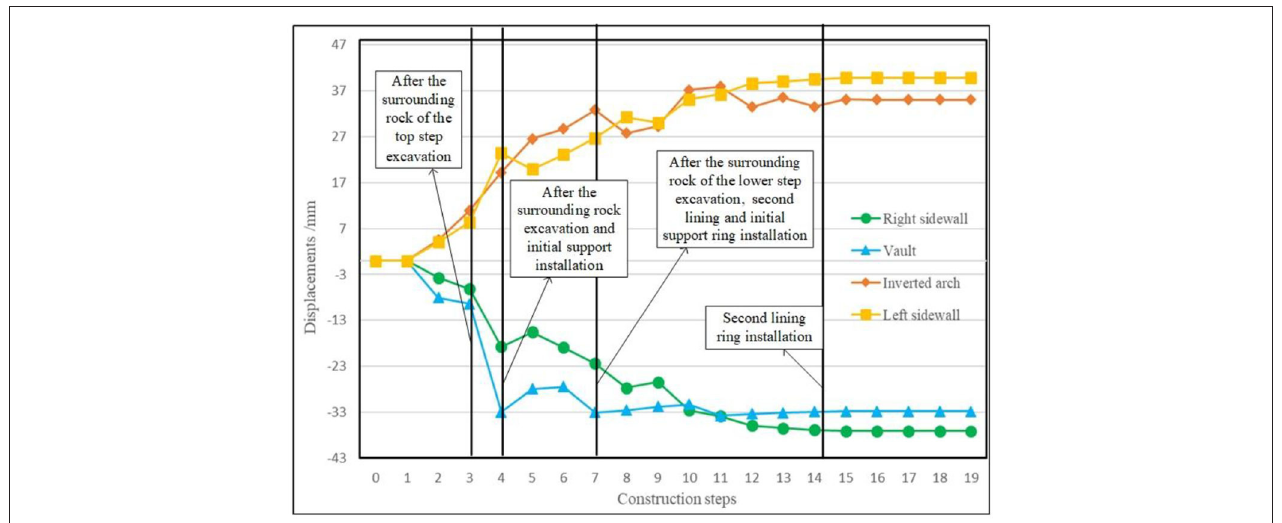
FIGURE 10 | Curves of displacements and construction steps of surrounding rock.